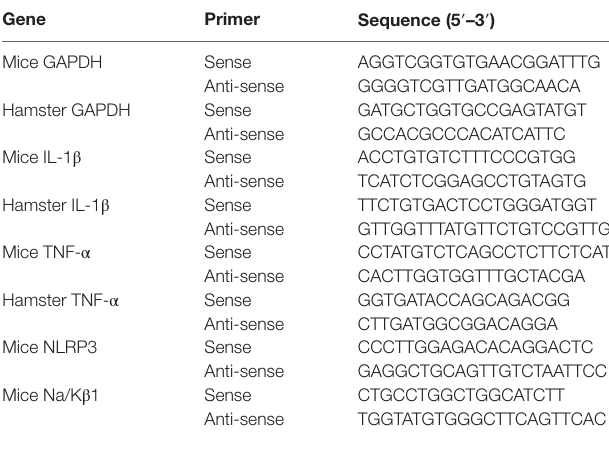
TaBle 1 | Sequence of primers used for quantitative polymerase chain reaction assays. gene Primer sequence (5 ′ –3 ′